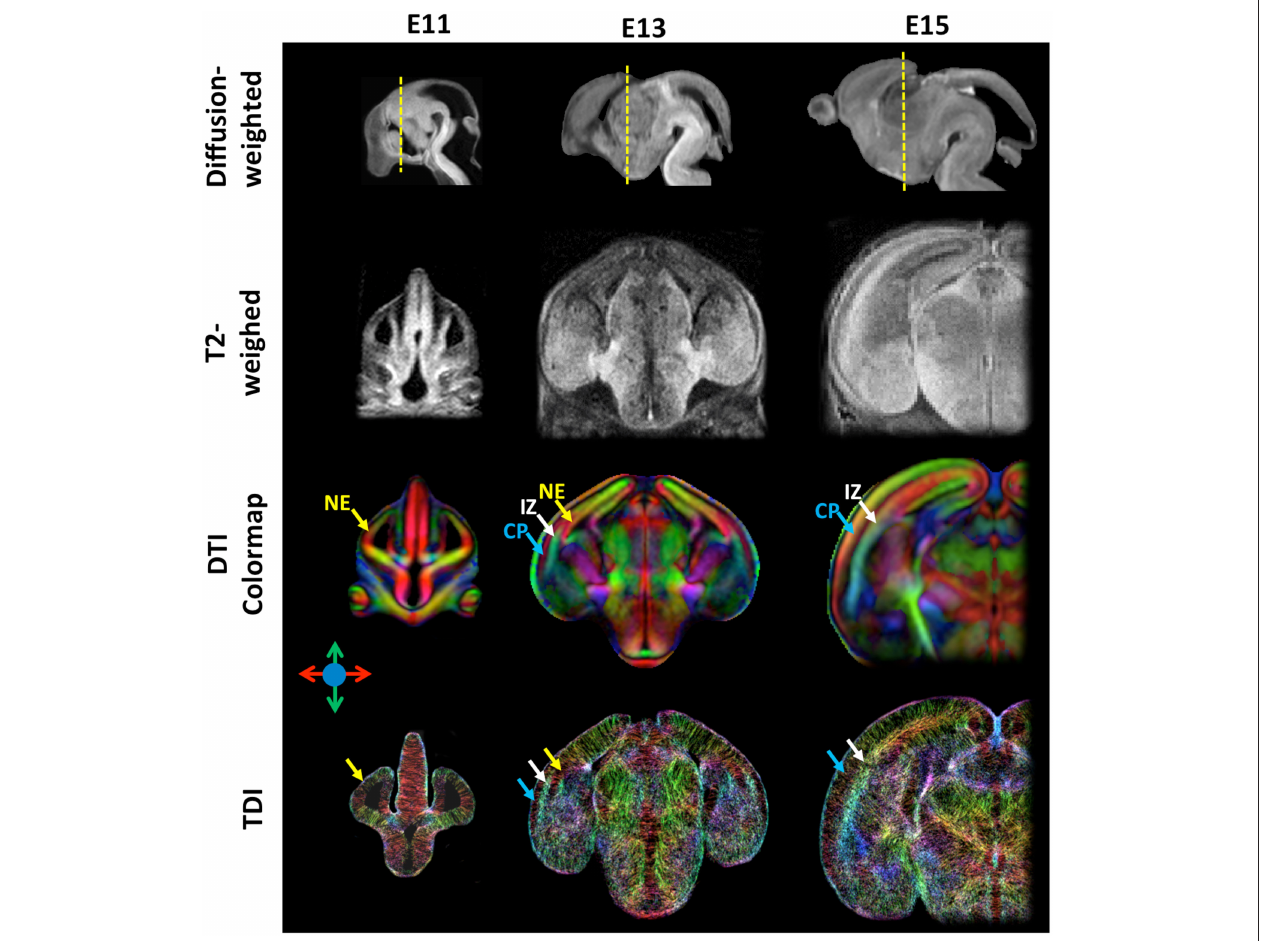
FIGURE 1 | High-resolution diffusion-weighted, T 2 -weighted, diffusion tensor directionally encoded colormap (DTI colormap), and track density images of embryonic mouse brains at embryonic day 11, 13, and 15. The diffusion-weighted images show the mid-sagittal plane of the mouse brain, and the T 2 -weighted, DTI colormap, and TDI data show a coronal plane as indicated by the yellow dash lines in the corresponding diffusion-weighted images. The MRI data were acquired at an isotropic spatial resolution of 0.03 mm, and the diffusion MRI data were acquired with 30 diffusion encoding directions and b -value of 1300–1500 s/mm 2 . Early cortical structures can be appreciated in the DTI colormaps and TDI data. Structural abbreviations are: CP, cortical plate; IZ, intermediate zone; NE, neuroepithelium. The color scheme used in the DTI colormaps and TDI are: red: left-right; green: ventral-dorsal; blue: rostral-caudal, as indicated by the color